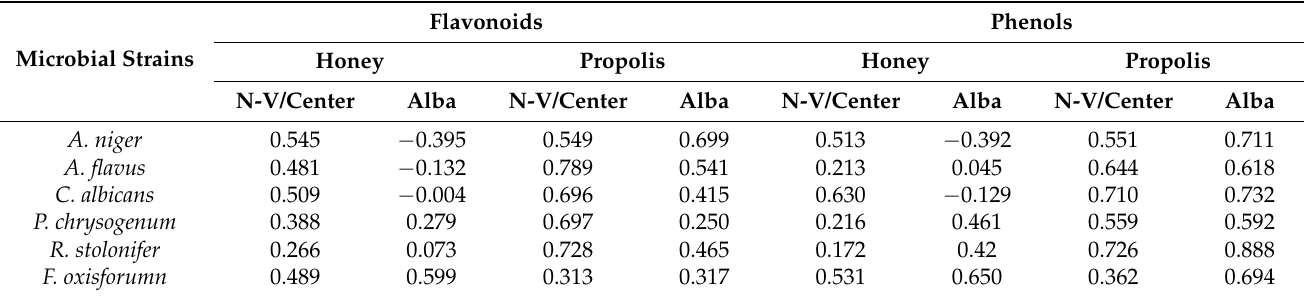
Table 13. Pearson’s correlation coefficients between the diameter of the inhibition zone and the flavonoid/phenol content for the studied microbial